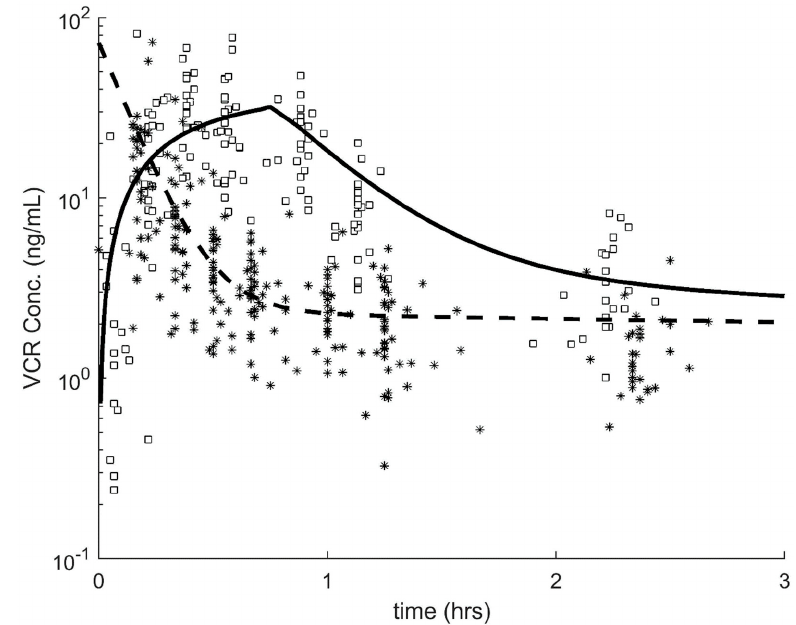
Figure 1. Vincristine concentration vs time plot. Black squares: 1 h infusion data; solid black curve: model fit to the 1 h infusion data; black stars: push data; dashed black curve: model fit to the push data.